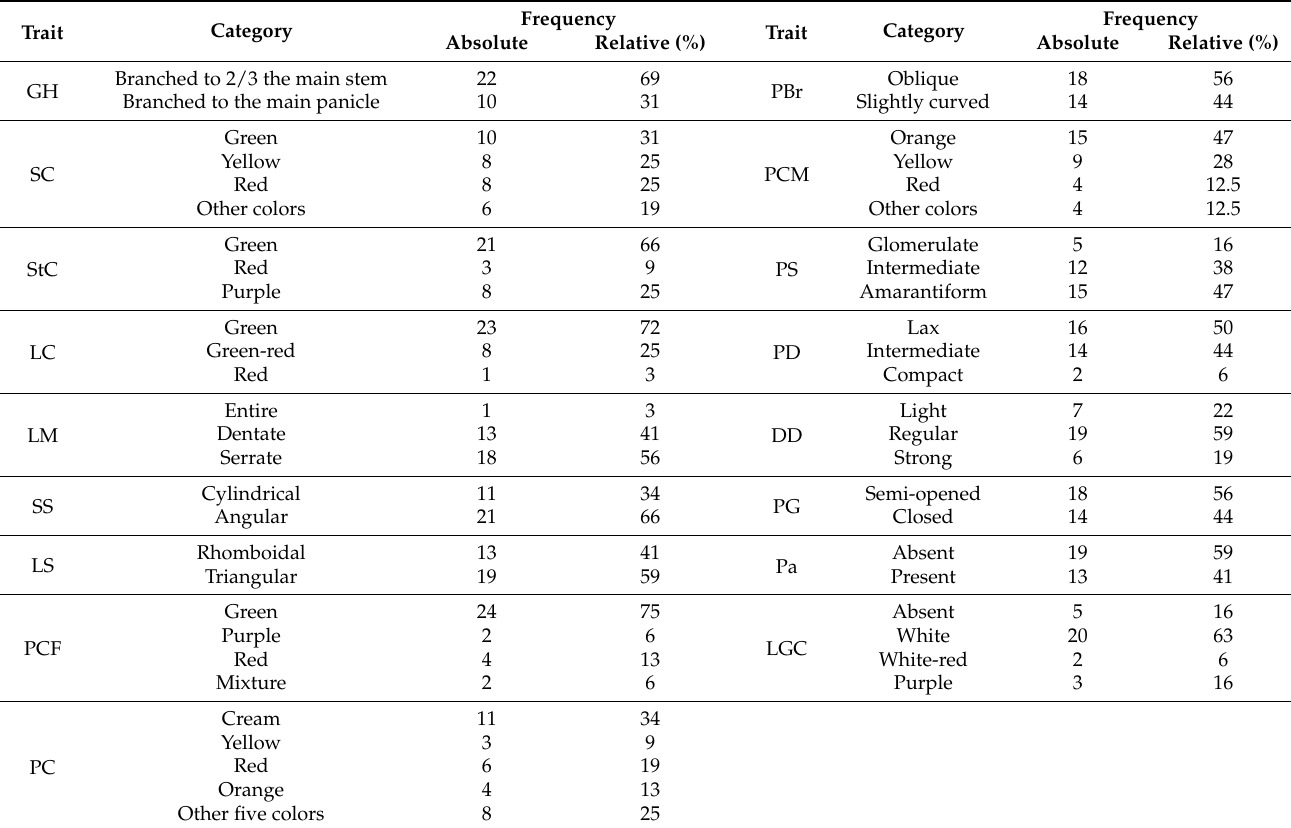
Table 2. Categories and absolute and relative frequency distributions of discrete variables of morphological characters of tested quinoa genotypes.